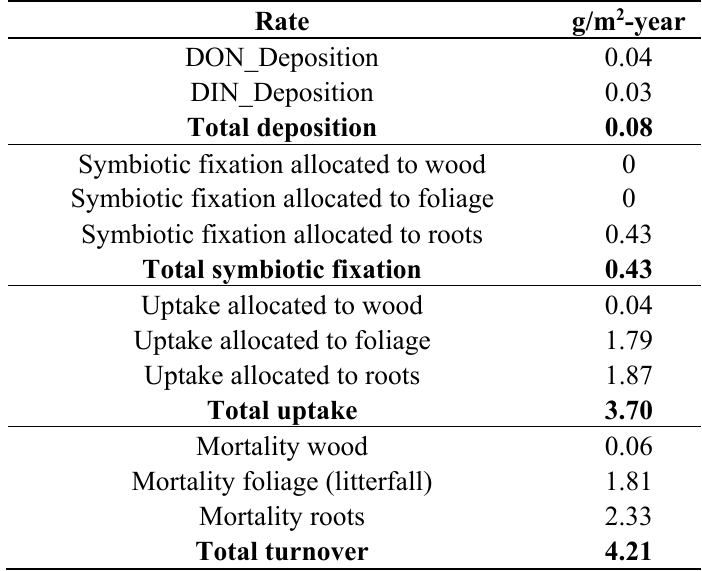
Table 11. Simulated average annual rates defining the nitrogen model. The rates in bold are summaries across each of the individual